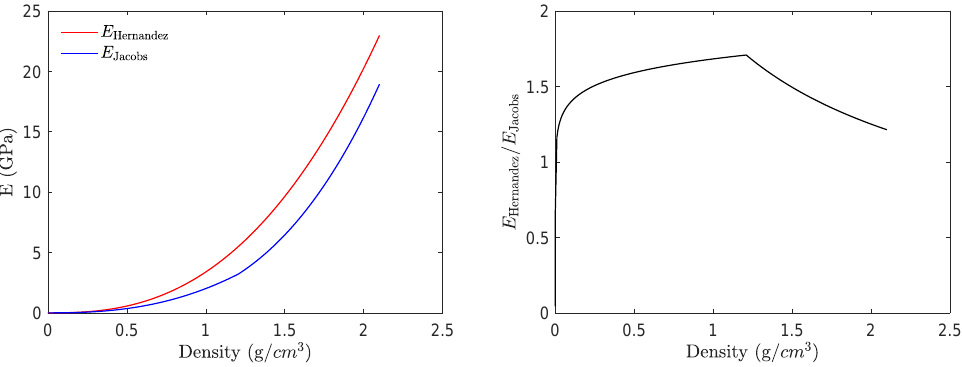
Figure 3. Comparison of the correlation provided by Jacobs [28] and the one derived from the correlation of Hernandez et al. [29] for the Young’s modulus as a function of bone apparent